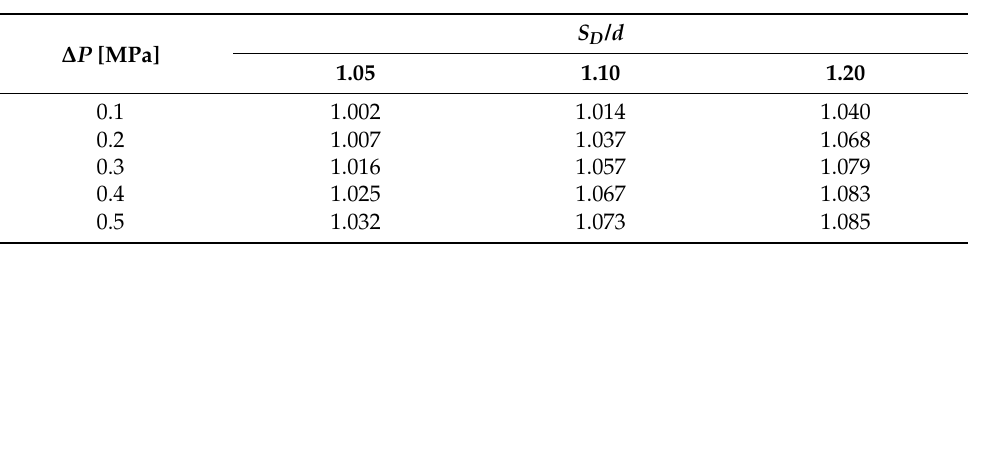
Figure 5. The curve fitting according to the polytropic process. Table 3. Value of n with different ∆ P and S D /d, where n is the polytropic exponent in the thermody- namics; ∆ P is the differential pressure between Inlet and